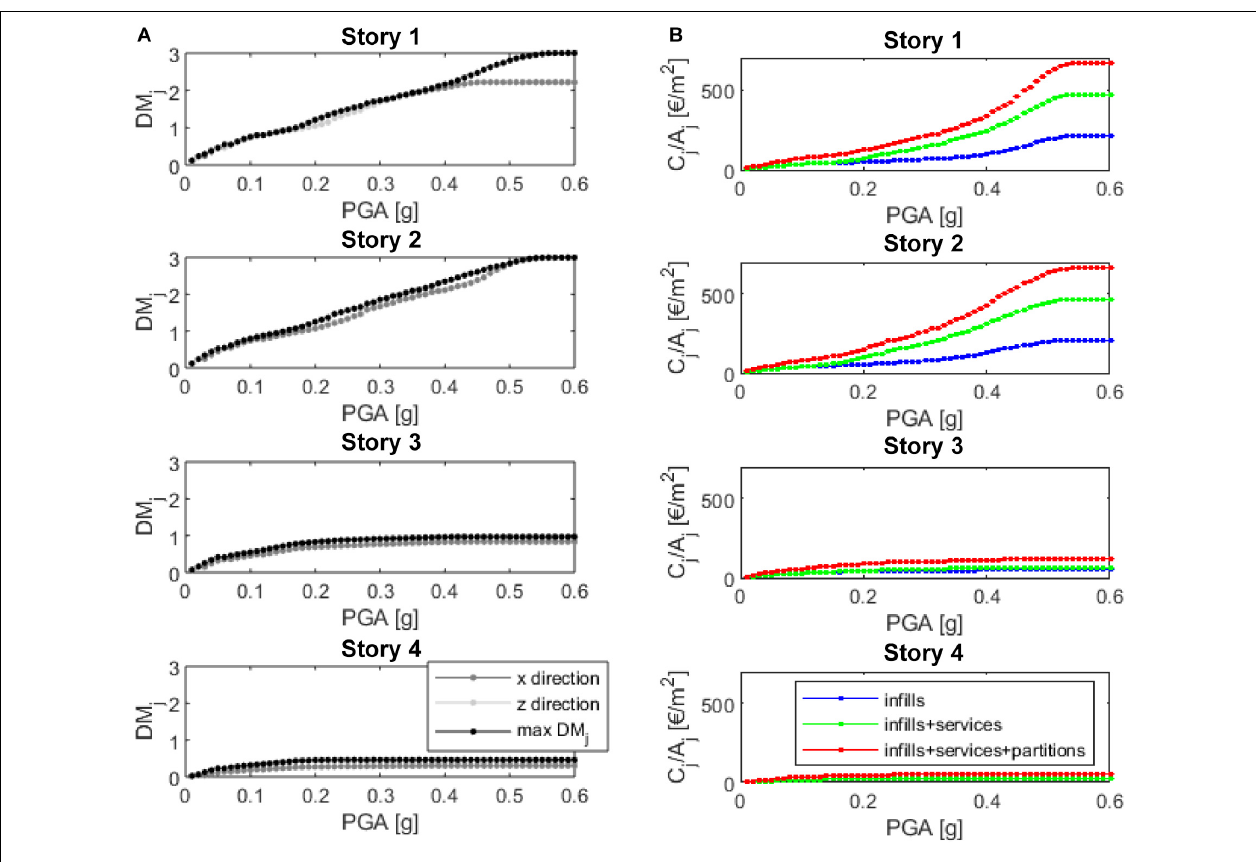
to be null at DS1 (see section “Repair Costs Due to Infills and